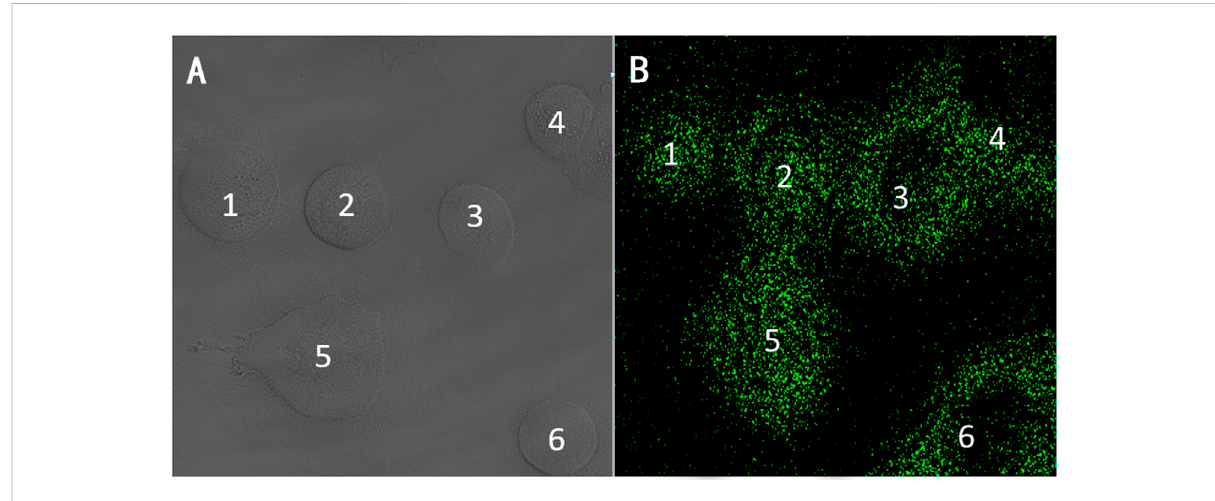
FIGURE 7 CLSM images after incubating A549 cells with Eu-CP-Ara. (A) Distribution of Eu-CP-Ara in A549 cells at the bright fi eld image for 24 h. (B) Distribution of Eu-CP-Ara cells at the dark fi eld image for 6 h after incubating A549 cells with Eu-CP-Ara.